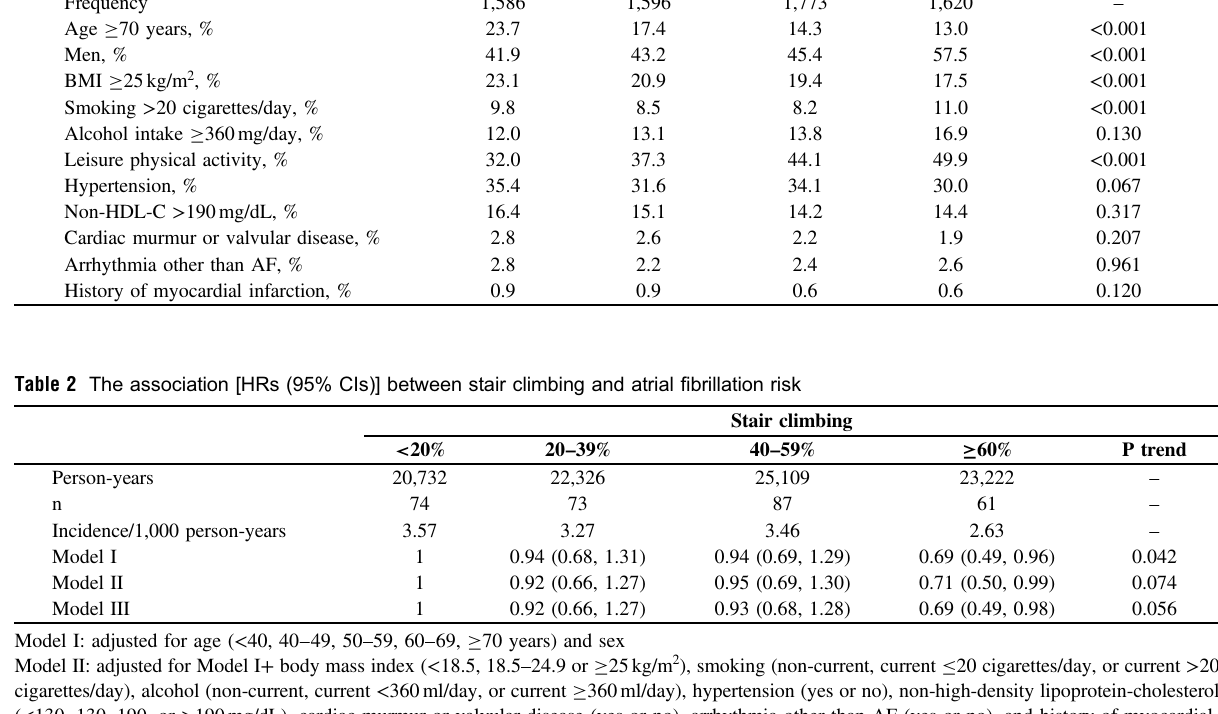
Table 1 Age-and sex-adjusted characteristics of participants by stair climbing